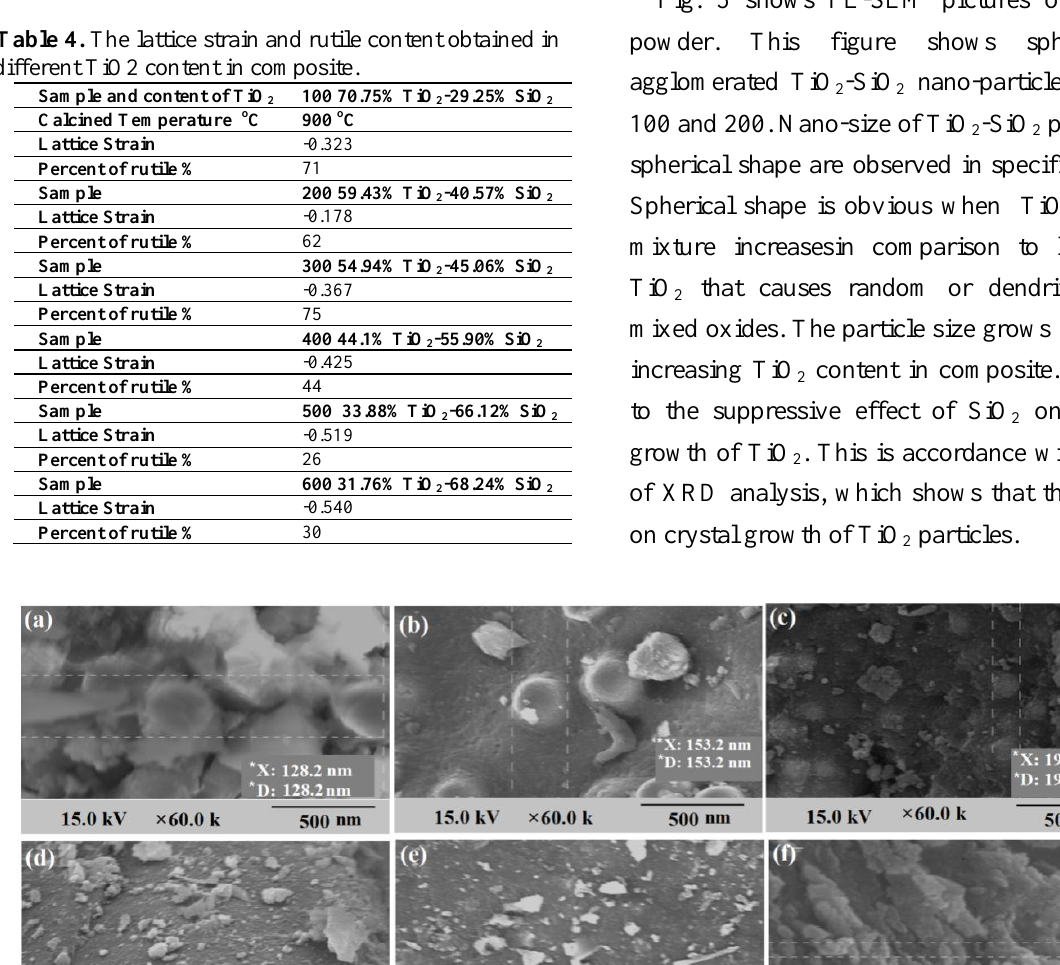
Fig. 6. TEM image of sample 100 of TiO nanoparticles that calcined at 900